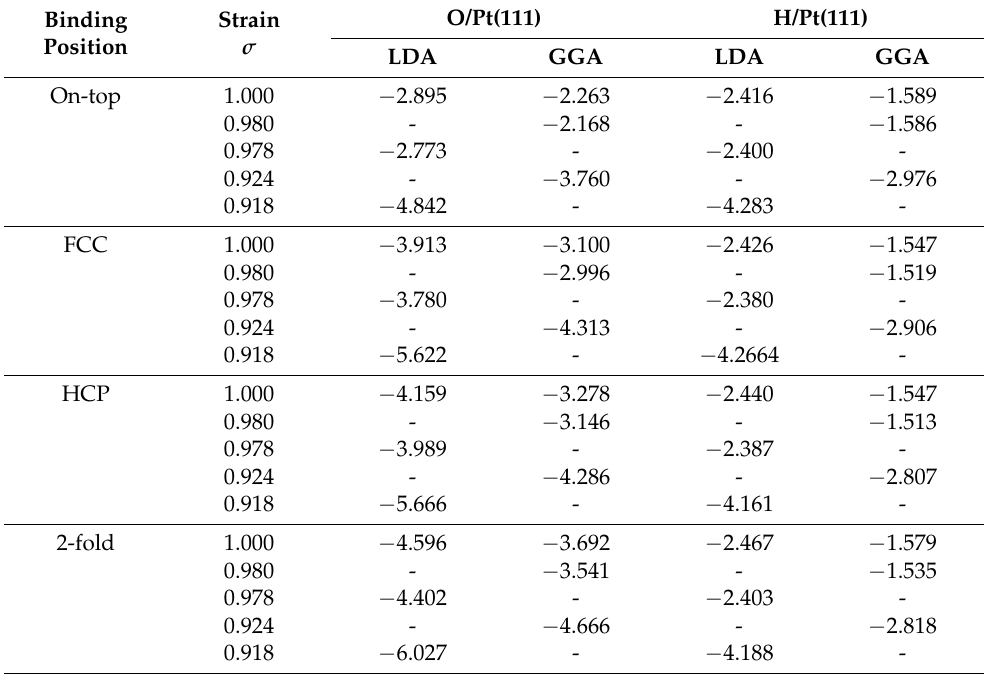
Table 2. Oxygen and hydrogen adsorption energies on strained Pt(111). The rightmost column sub- headings (‘LDA’/‘GGA’) indicate the exchange-correlation functional used. The strains used are those estimated within a Pt surface layer formed on a Pt 3 Ni alloy (0.980/0.978) using the GGA and LDA approximations, respectively, and similarly (0.924/0.918) for a PtNi 3 alloy. All energies are in